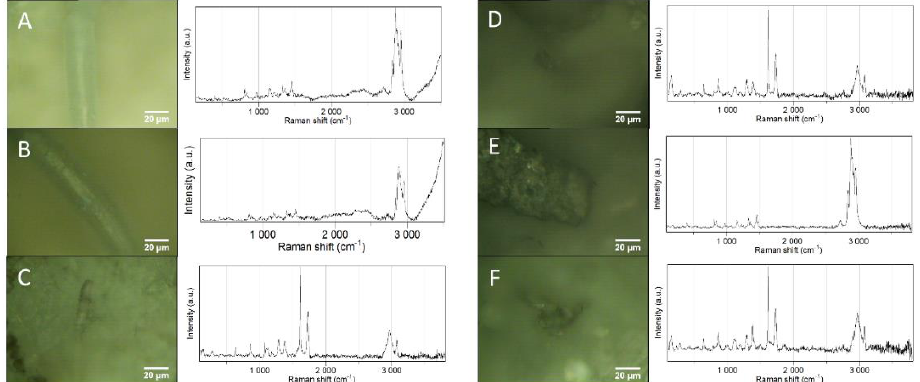
Figure 1. Raman spectra of microplastics found in the filters of samples of internal tissues of different companion animals: ( A , B ) polypropylene particle in cat liver; ( C ) polyethylene terephthalate particle in cat ileum; ( D ) polyethylene terephthalate in cat blood clot; ( E ) polypropylene particle in dog lung; ( F ) polyethylene terephthalate particle in dog lung. Edited in Adobe Photoshop CS6 to improve brightness and contrast by 50 and 30, respectively. Original colors can be found in Figure S2, Supplementary Materials.